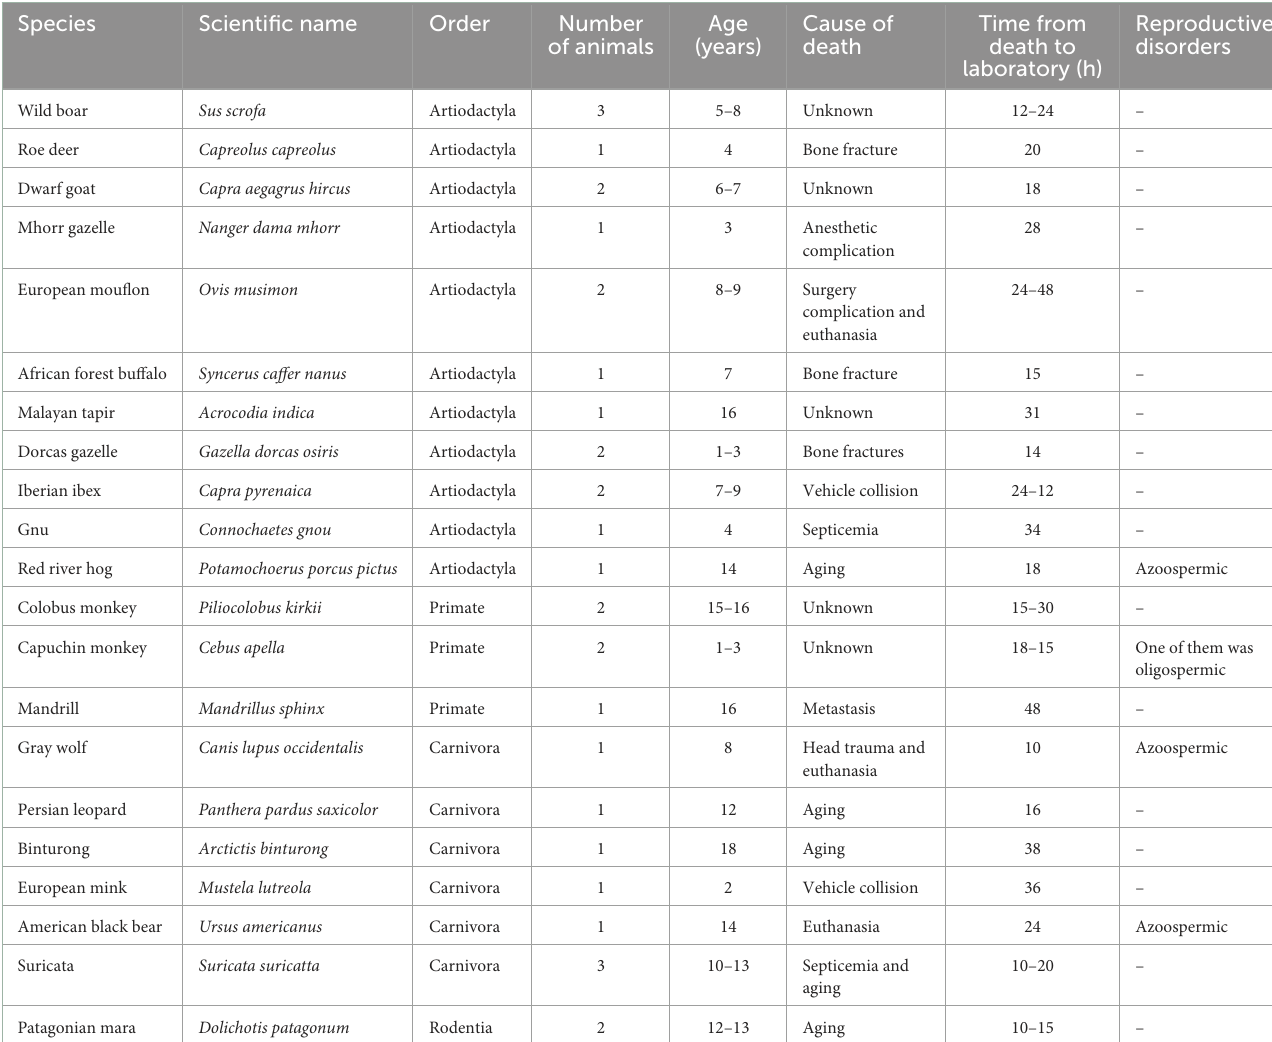
TABLE 1 General information about the animals ( n = 33) used in the